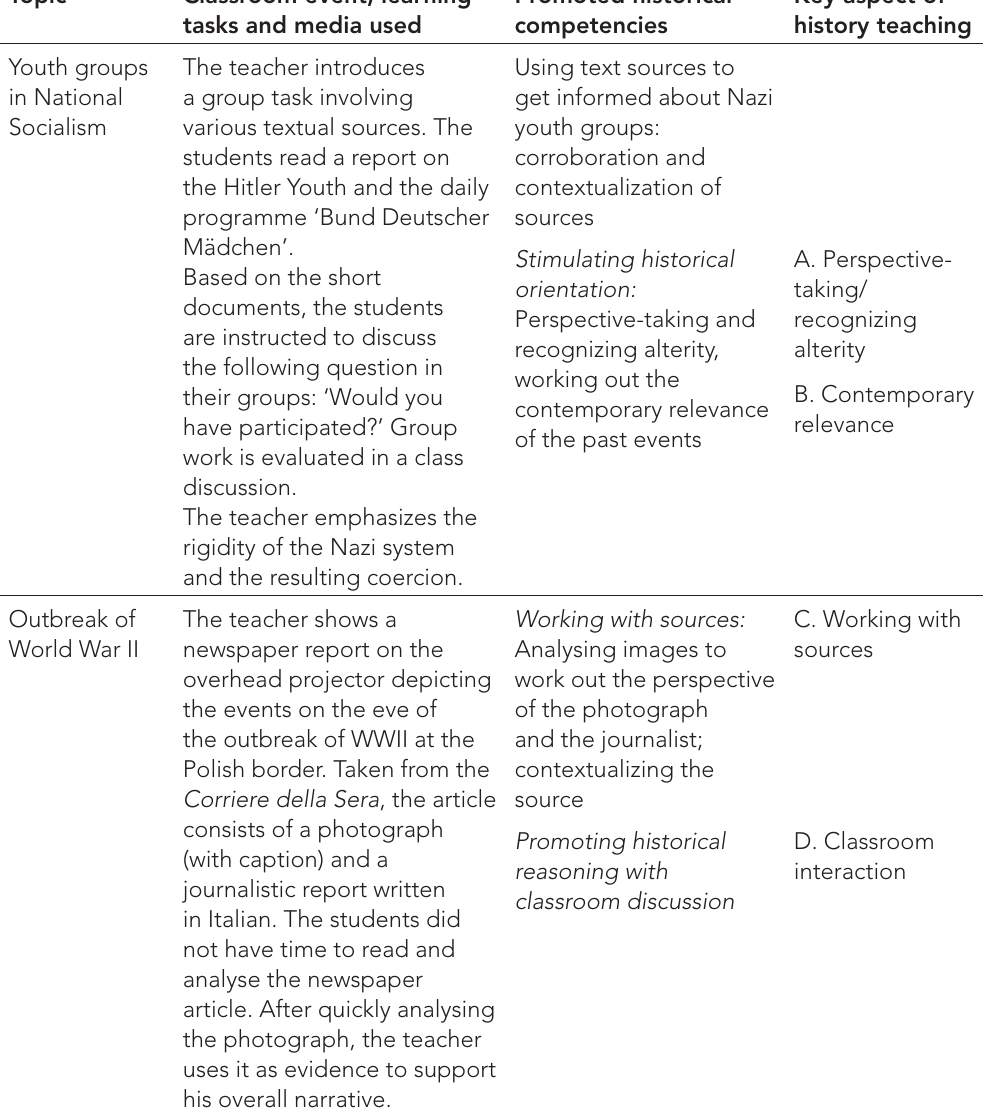
Table 2: Video clips selected and their potential to foster historical competencies Topic Classroom event,